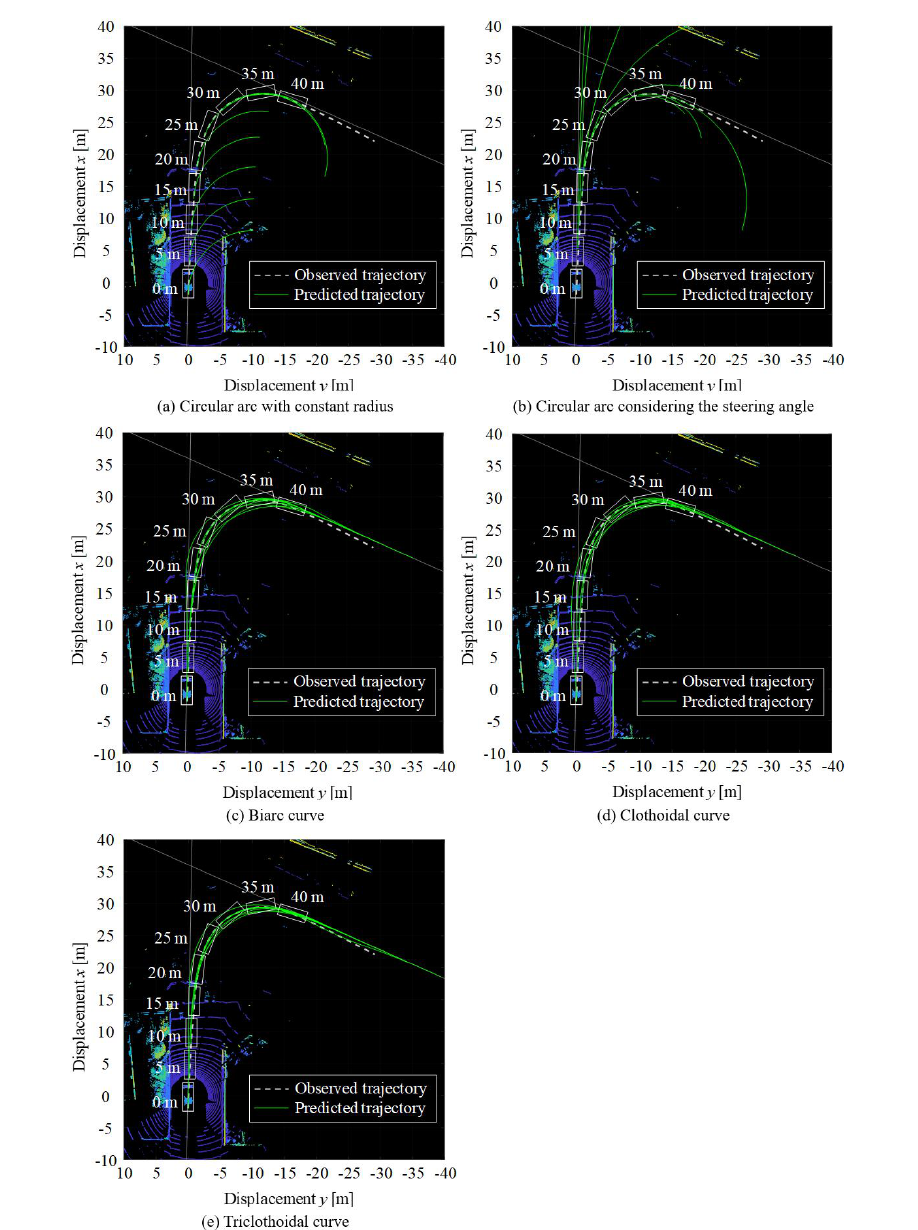
Figure 6. An example of the trajectory prediction in a real intersection by the trajectory prediction methods: ( a ) circular arc with constant radius; ( b ) circular arc considering the steering angle; ( c ) Biarc curve; ( d ) Clothoidal curve; and ( e ) Triclothoidal curve. The prediction methods that require defi- nition of the terminal point could predict the trajectory with high accuracy before getting into the intersection. The Triclothoidal curve, especially, could predict the trajectory with fewer deviations from the actual